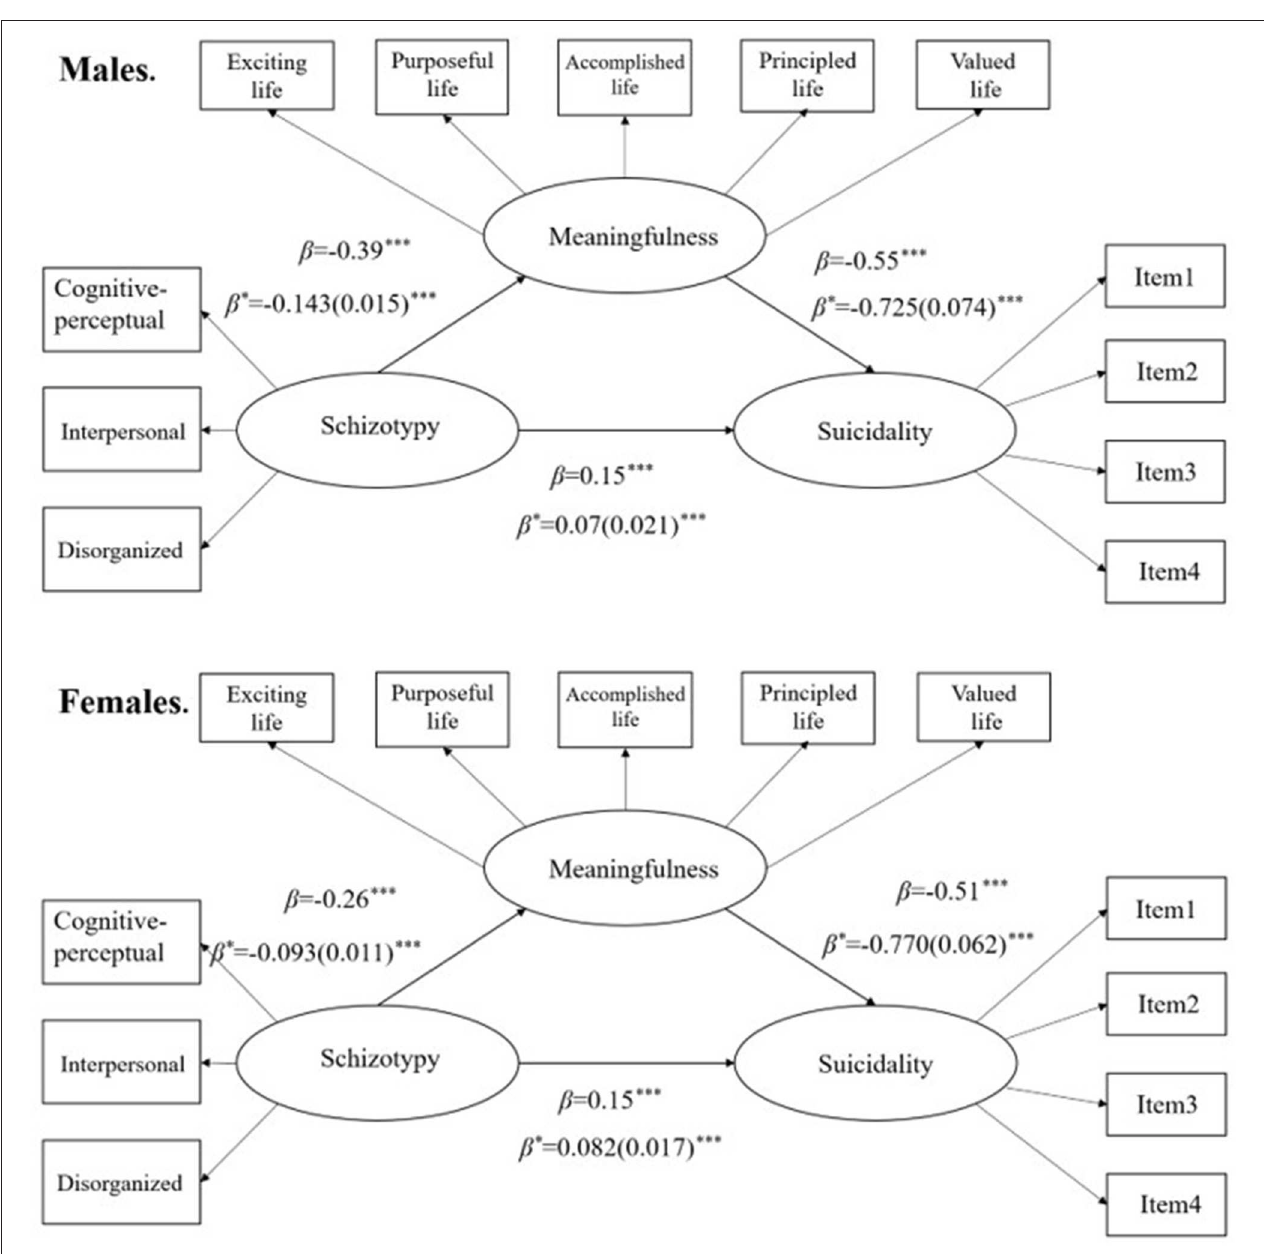
FIGURE 3 | Mediation model for relationship among schizotypy, meaningfulness, and suicidality in males (upper half) and females (lower half). *** p < 0.001, β , standardized coefficients; β * , unstandardized coefficients; SE, standard errors in brackets.